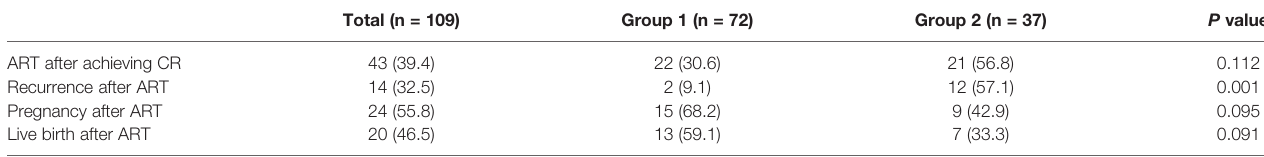
TABLE 6 | Effect of assisted reproductive technology on outcomes of atypical endometrial hyperplasia and endometrial cancer after fertility-preserving treatment (%). Total (n = 109) Group 1 (n = 72)